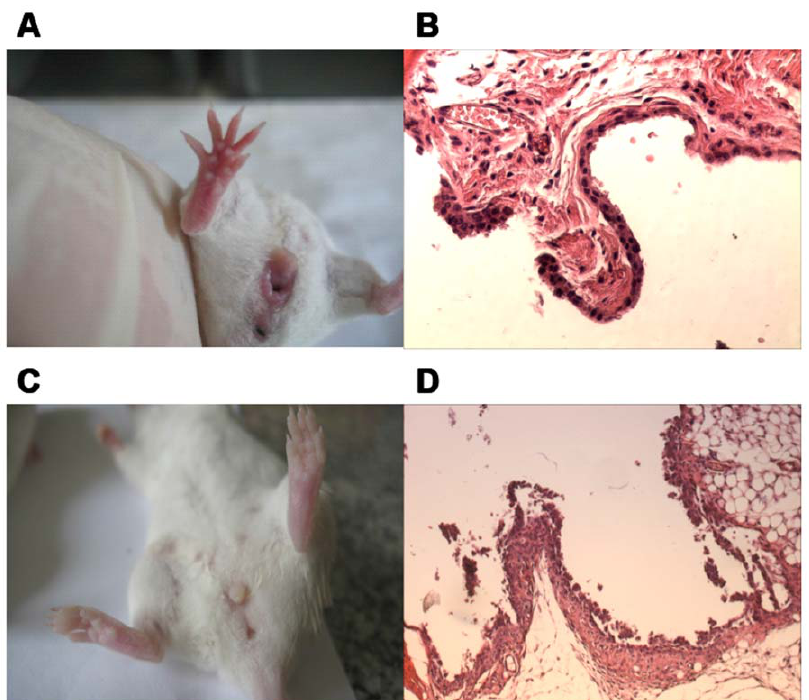
Figure 2. Morphological inflammation of erythematous and edematous paws and histochemical lesions of synovial hyperplasia and inflammatory infiltration in BIA-CIA mice. A and B. BIA-CIA mice (intra-dermal CII-CFA injection); C and D. BIA-CIA mice (intra-articular CII- CFA injection). HE staining of sections and microscopic analysis were carried out by sampling hind paws of mice after modeling of BIA-CIA mice (intra- dermal CII-CFA injection) for 28 d and after modeling of BIA-CIA mice (intra-articular CII-CFA injection) for 3 d, respectively. The histochemical photographs were amplified for 100 folds. doi:10.1371/journal.pone.0034494.g002 (Figure 5A and B). This result indicated that glycolysis for anaerobic degradation of carbohydrates must be enhanced